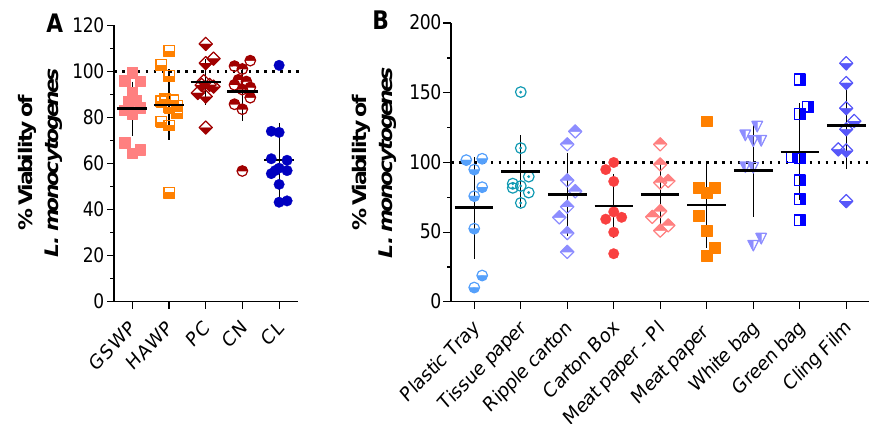
Figure 1. Effect of the base material on the metabolic activity of 5 × 10 6 cells/cm 2 L. monocytogenes expressed as percentage viability. ( A ) Laboratory acquired materials mixed cellulose filters GSWP (0.22 µ m) and HAWP (0.45 µ m); polycarbonate (PC—0.4 µ m); cellulose nitrate (CN—0.45 µ m) and cellulose (CL). ( B ) Commercially obtained cellulose-based and ‘plastic’ materials. Each data set represents the mean and SD (standard deviation) of eight and six technical repeats for the laboratory and commercial materials, respectively.